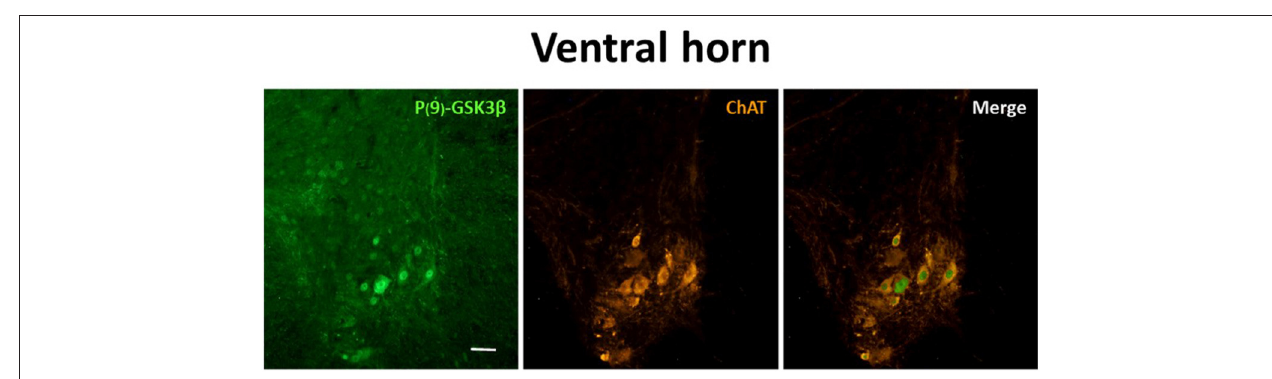
FIGURE 6 | Representative pictures showing the double staining for P(9)-GSK3 β (inactive form of GSK3 β ; left panel, secondary conjugated with Alexa-488), choline-acetyltransferase (ChAT; to mark motor neurons; central panel, secondary conjugated with Alexa-555) and merging (right panel). Pictures were taken during the synthetic torpor at nadir of hypothermia (N condition, see Figure 1 ), framing the only ventral horn of a cervicothoracic region of the spinal cord. Calibration bar: 100 µ m.